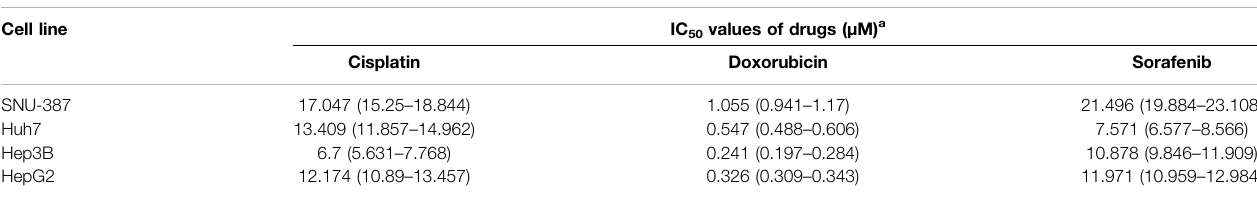
TABLE 2 | IC 50 values for cisplatin, doxorubicin, and sorafenib treatment in HCC cell lines. Cell